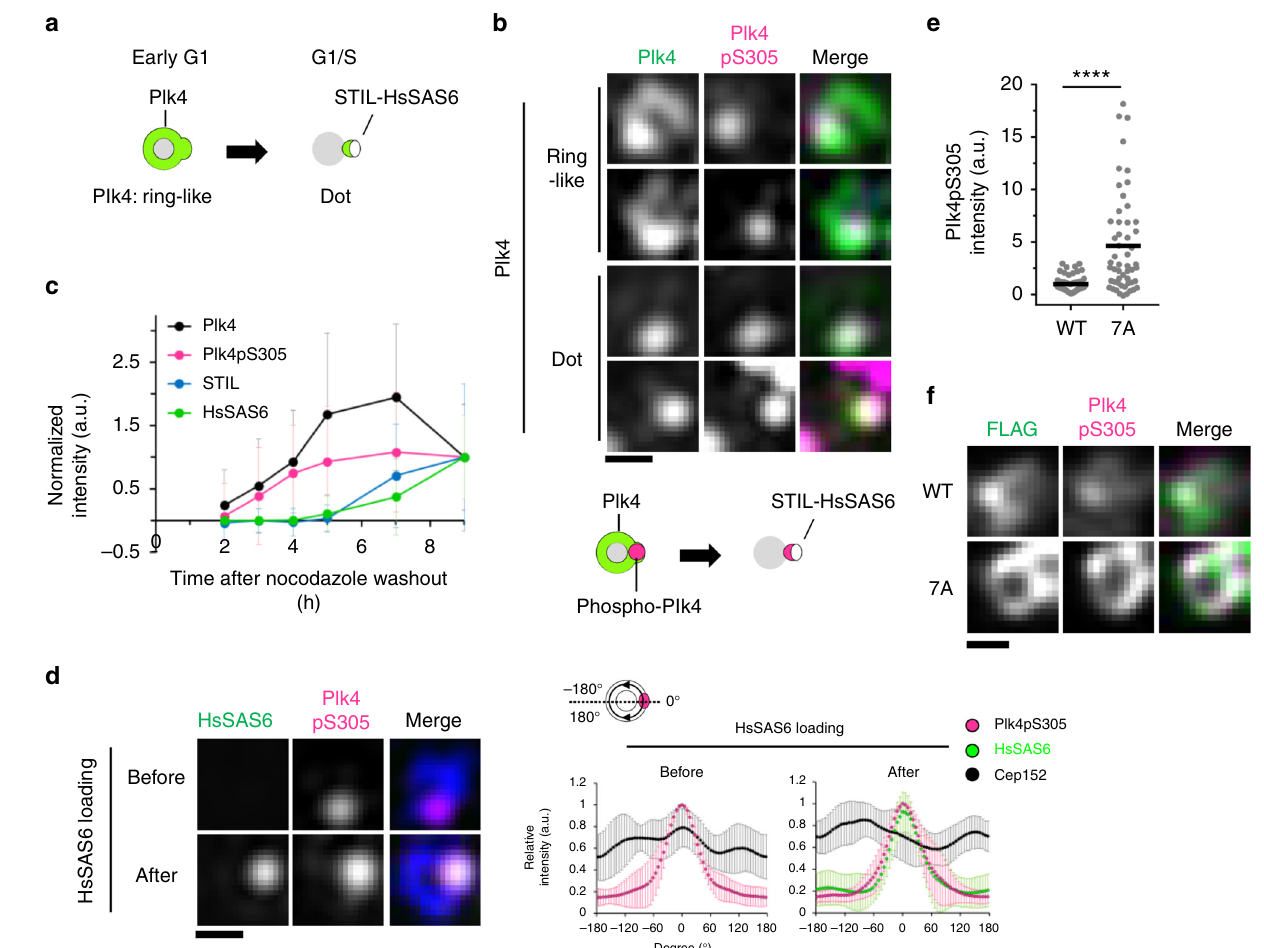
Fig. 4 A single focus of autophosphorylated Plk4 is generated prior to STIL-HsSAS6 loading. a Schematic of Plk4 distribution around mother centrioles in centriole duplication. b 3D-SIM images of centrioles immunostained with the indicated antibodies in HeLa cells. Cep152 was costained and used for a marker of mother centriole wall. Scale bar, 0.3 μ m. c Quanti fi cation of centriolar Plk4, Plk4pS305, STIL, and HsSAS6 intensities during G1 phase. Cells